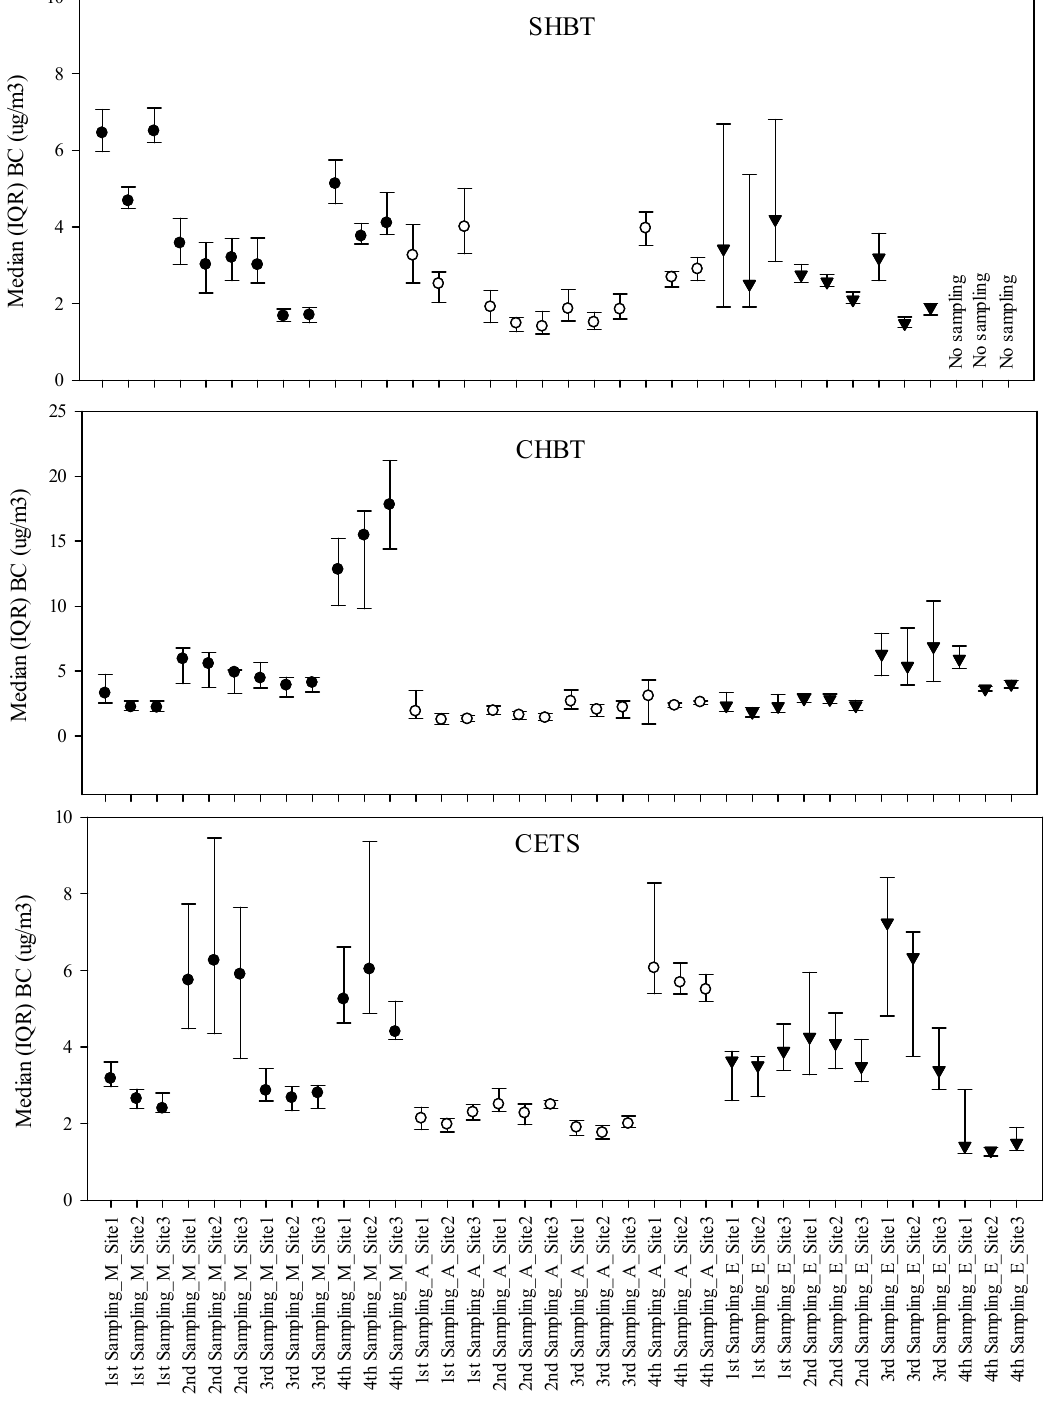
Figure A2. Distributions of BC concentrations (Median (IQR)) of simultaneous measurement for three sites according to sampling place (SHBT, CHBT, CETS), sampling day (1st to 4th trial) and sampling time (Morning, Afternoon, Evening).